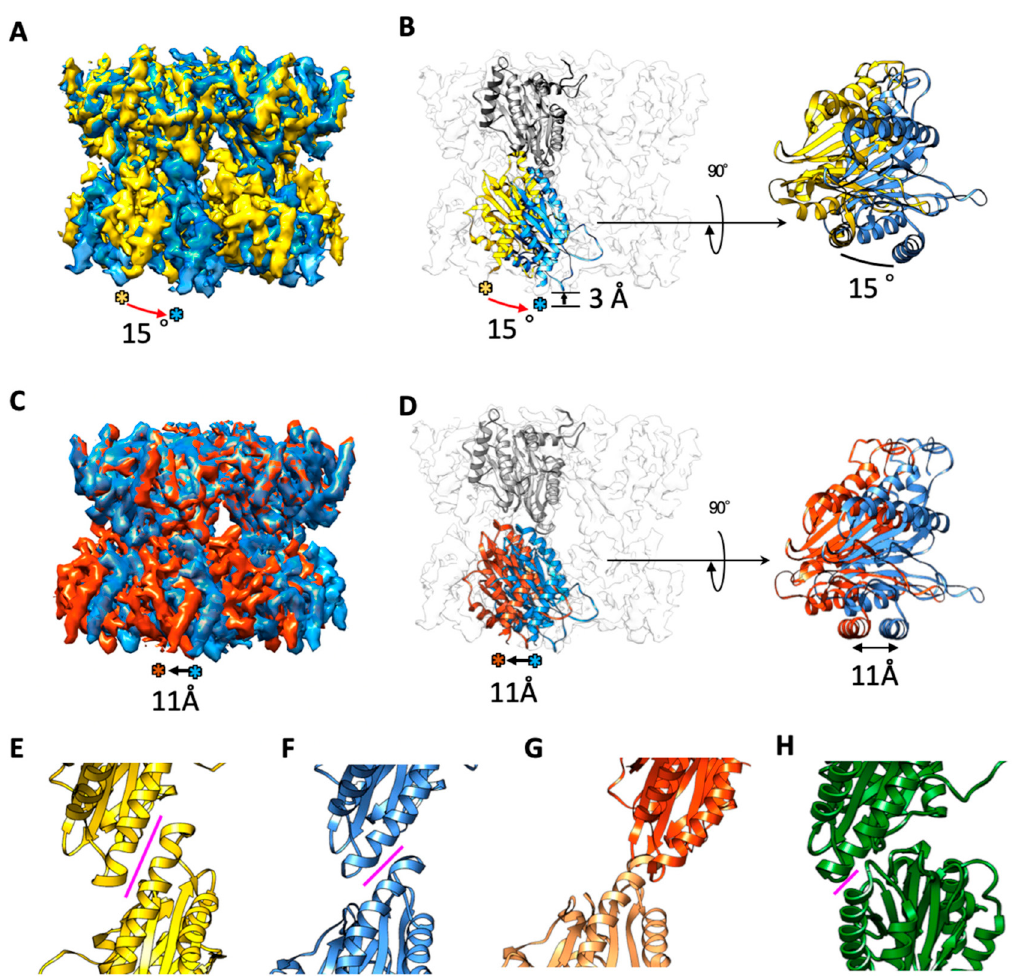
Figure 3. Structural comparison of the α 7 homo-tetradecamer between the cryo-EM models and the X-ray crystallographic model. ( A ) Cryo-EM map of the symmetric-type α 7 homo-tetradecamer (blue) was superimposed with the X-ray crystal- lographic model (PDB ID: 5DSV; yellow). When the upper ring of the double ring was overlapped at the same position, the dislocation of the lower ring was evaluated. ( B ) Ribbon diagrams of the α 7 subunits in each lower ring are colored by blue (cryo-EM) and yellow (X-ray). The cryo-EM model shows a clockwise twist of approximately 15 ◦ and a separation of approximately 3 Å compared to the X-ray crystallographic model. ( C ) Cryo-EM map of the dislocated type of the α 7 homo-tetradecamer (red) overlapped with that of the symmetric type (blue). When the upper ring of the double ring was overlapped at the same position, the dislocation of the lower ring was evaluated. ( D ) Ribbon diagrams of the α 7 subunits in each lower ring are colored by blue (symmetric) and red (dislocated). The lower ring was offset by approximately 11 Å in the dislocated type. ( E – H ) Helix–helix interactions between the two rings of the α 7 homo-tetradecamer: X-ray crystallographic model ( E ) and cryo-EM symmetric ( F ), dislocated ( G ), and open ( H ) types. The magenta line represents a possible interaction area. The length of the helix–helix interaction was measured as 13 Å in ( E ), 8 Å in ( F ), 9 Å in ( G ), and 6 Å in ( H